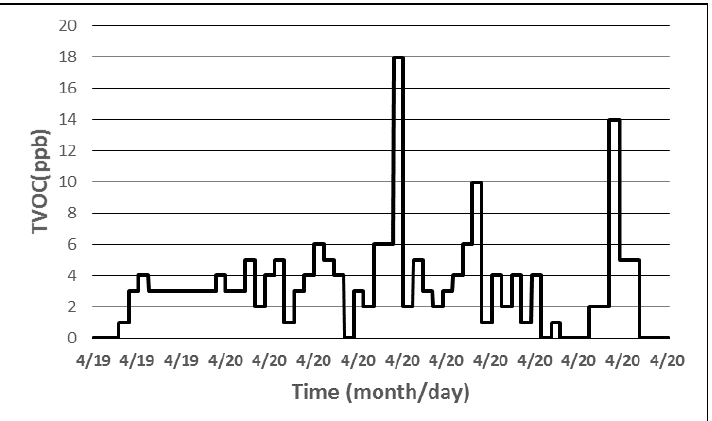
Figure 12. eCO 2 concentration level measured.